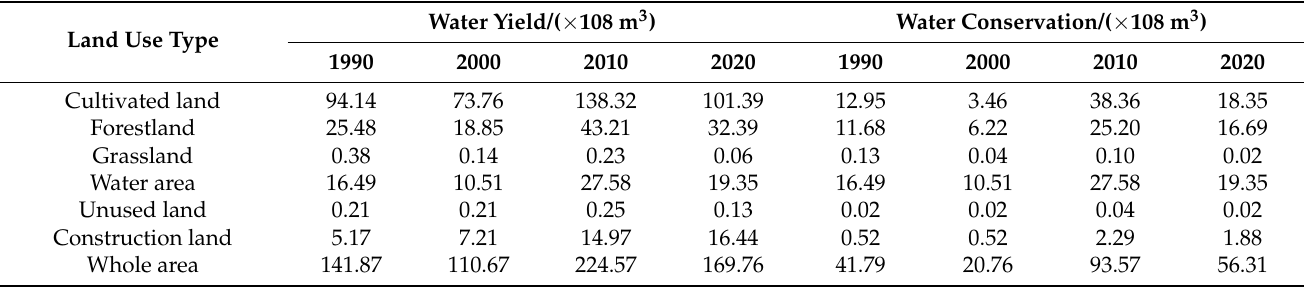
Table 4. Water yield and water conservation of different land use types during 1990–2020.